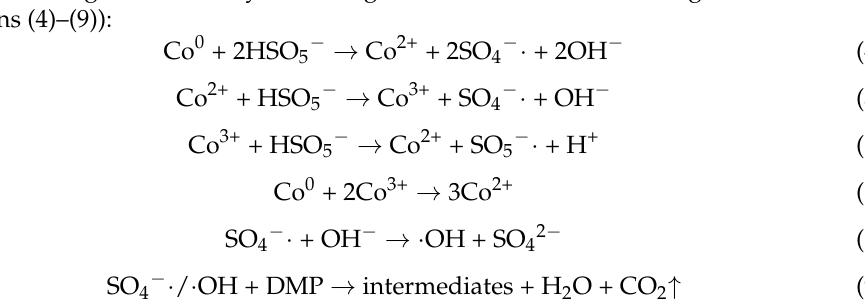
(Figure 8b) of Co 2p, peaks located at 778.6/794.8 eV (14.0%), 782.6/797.8 eV (42.1%) and 780.9/796.5 eV (43.9%) corresponded to Co 0 , Co(II) and Co(III), respectively [40,41].